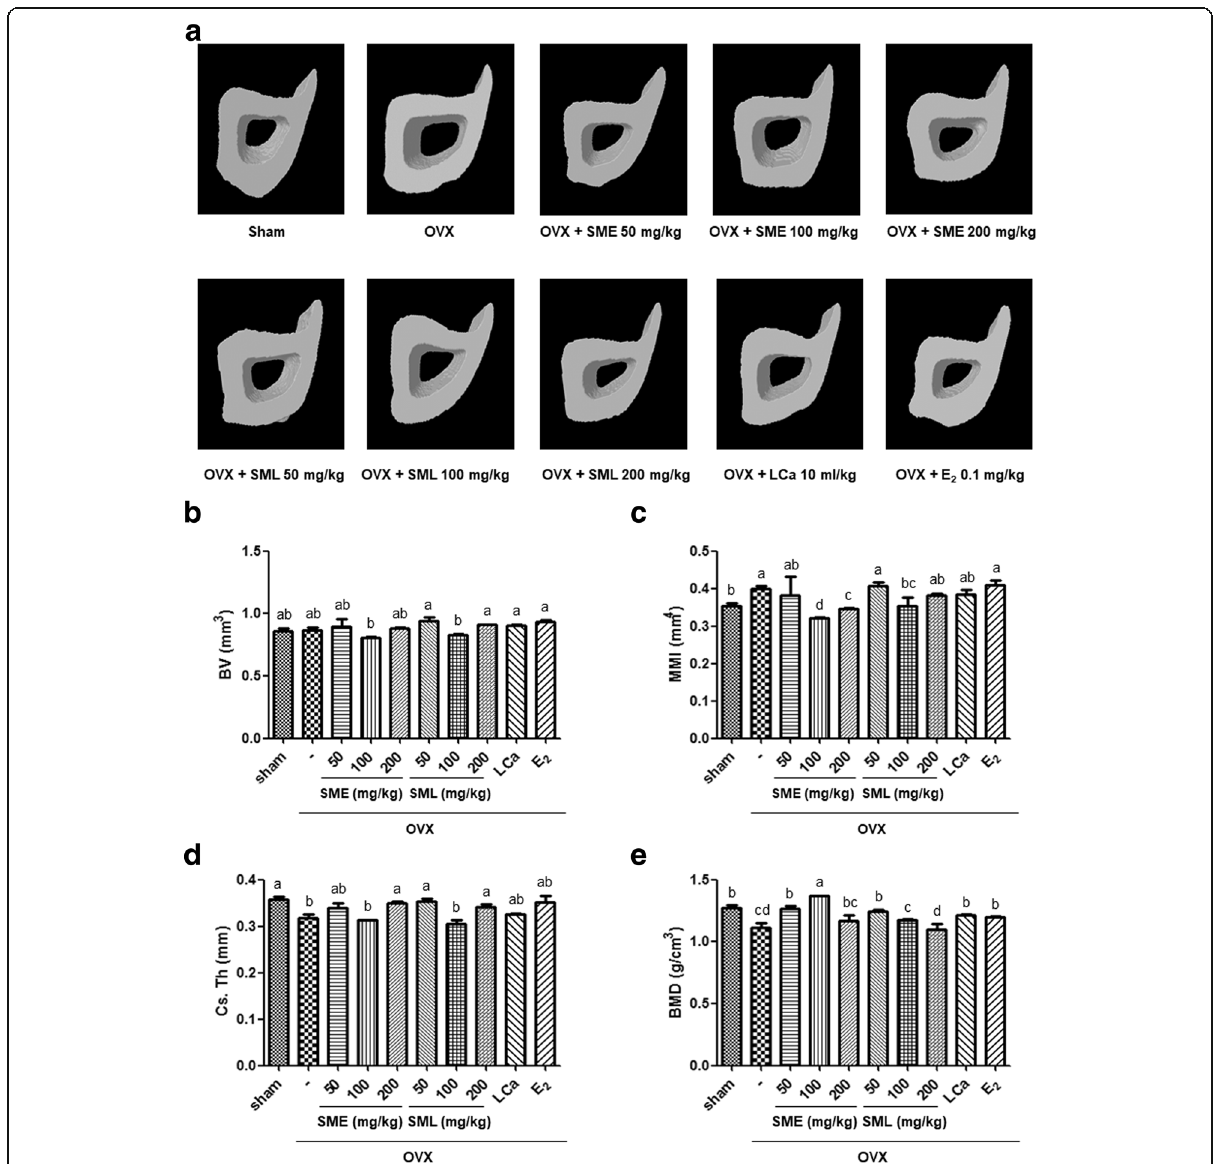
Fig. 2 Effects of SML on the structural characteristics of cortical bone. a Three-dimensional micro-CT images of cortical bone after 12 weeks in OVX mice. The cortical bone parameters were measured by a three-dimensional micro-CT analysis program. The measured cortical bone parameters were b bone volume density (BV, mm 3 ), c mean polar moment of inertia (MMI, mm 4 ), d cross-section thickness (Cs.Th, mm), and e bone mineral density (BMD, g/cm 3 ). Values are given as the mean±S.E.M. of three independent experiments (n=7) for all groups. Means unlike letters in a column with differ significantly ( p